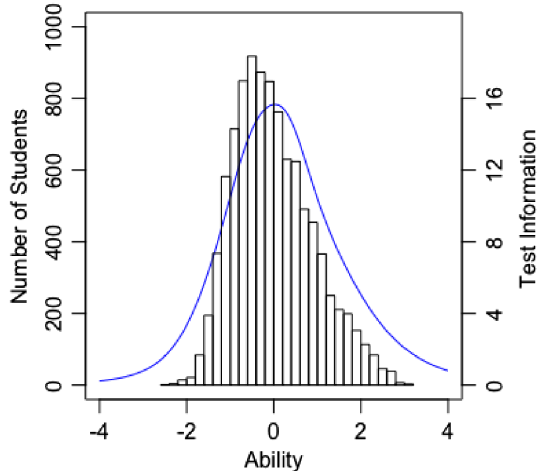
FIG. 10. Plotted in the CSEM scale, the histogram of estimated student abilities for the CSEM is overlaid with the CSEM ’ s test information curve. This shows that the bulk of the students are located in a region of ability space where their latent abilities will be well